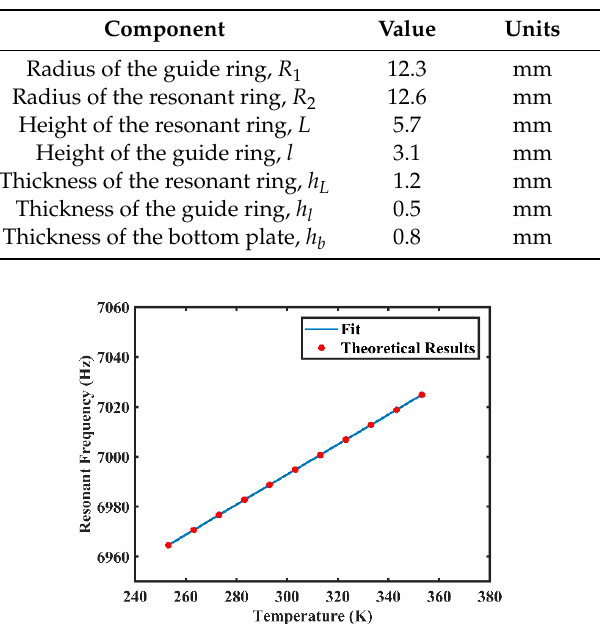
Table 2. Geometry parameters of the cylindrical resonator.